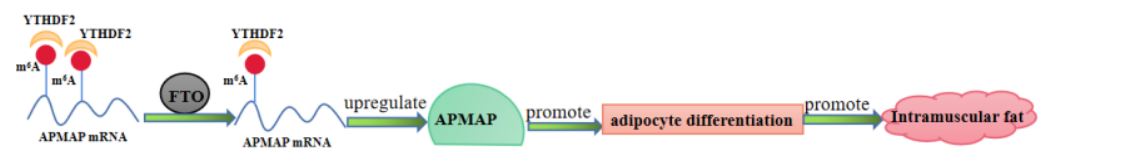
Figure 7. Regulatory mechanisms by which FTO affects intramuscular fat of Rex rabbits through m 6 A/YTHDF2/APMAP pathway.